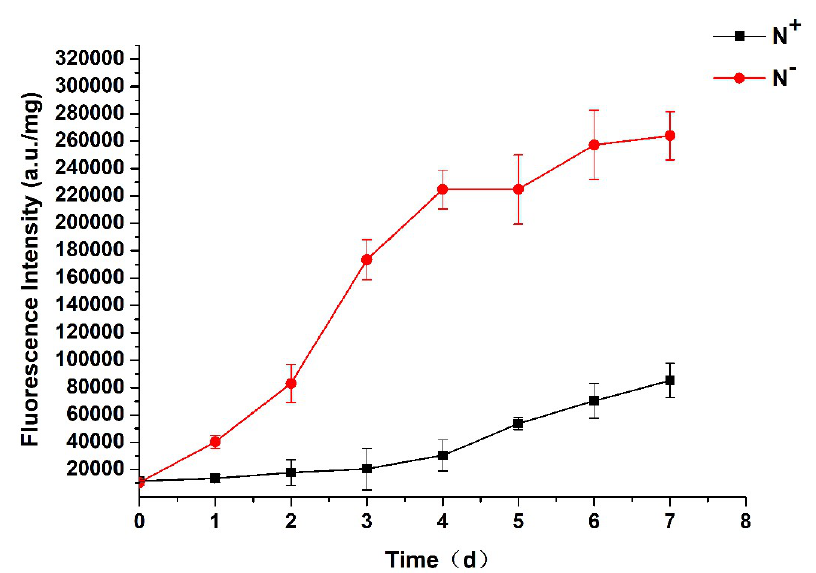
Figure 5. Comparison of neutral lipid contents of Parachlorella kessleri TY02 under N + and N − culture media. Data are shown as mean ± SE. n = 3.